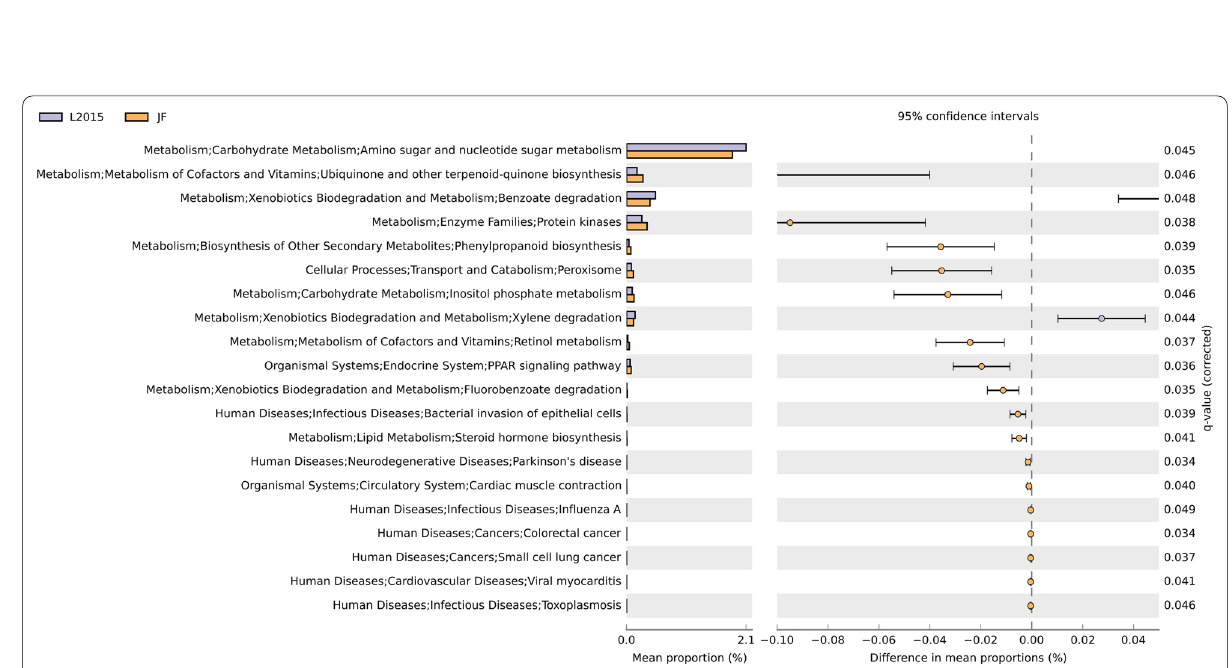
Fig. 5 Predicted functions of ileal content microbiota in modern random bred chickens (L2015) compared to their ancestor jungle fowl (JF) on d 56. Differentially regulated metabolic pathways are shown. (n